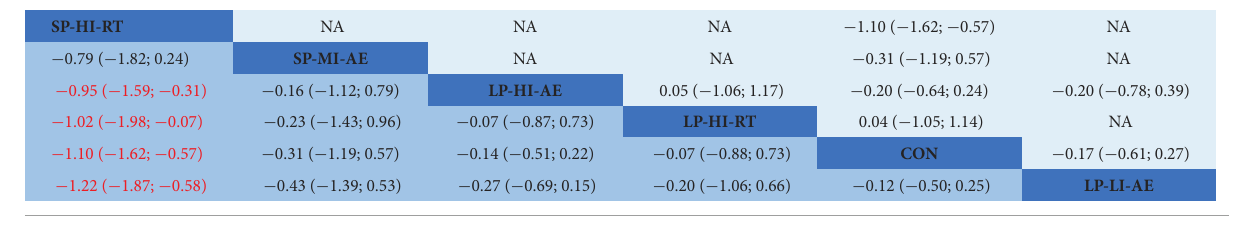
TABLE 5C Network meta-analysis of the efficacy of TWM.